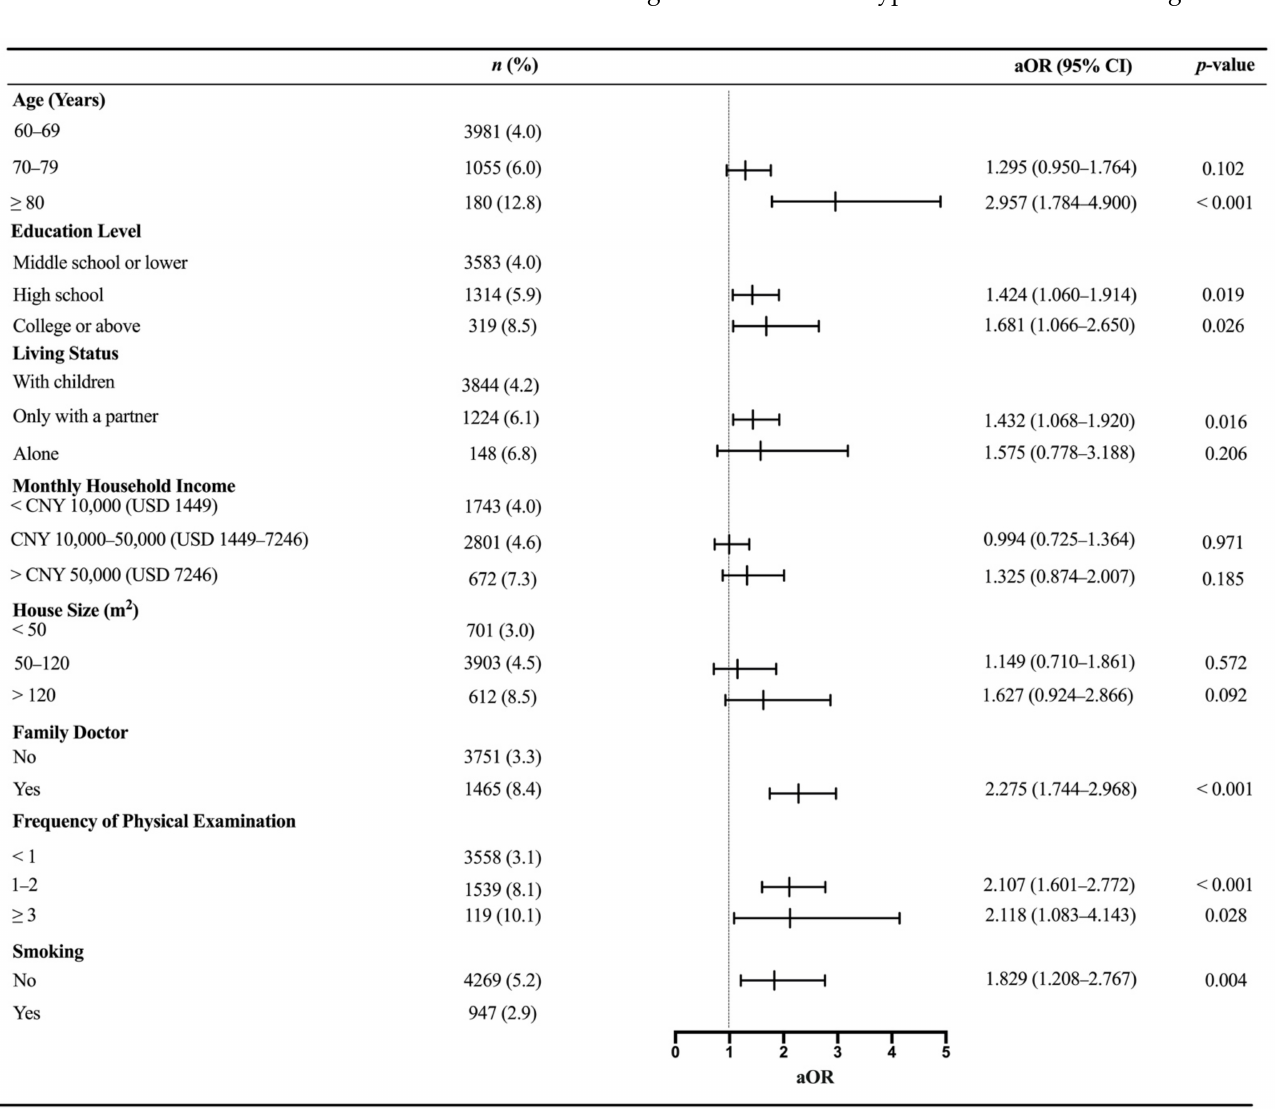
Figure 1. Factors for influenza vaccinations among the elderly with hypertension. aOR: adjusted odd ratio; CI: confidence interval. n indicates the numbers of each category. % indicates the influenza coverage rates. Variables included in the multivariable logistic regression analyses model after adjustments for age, education level, living status, monthly household income, house size, use of a family doctor, frequency of physical examinations, and